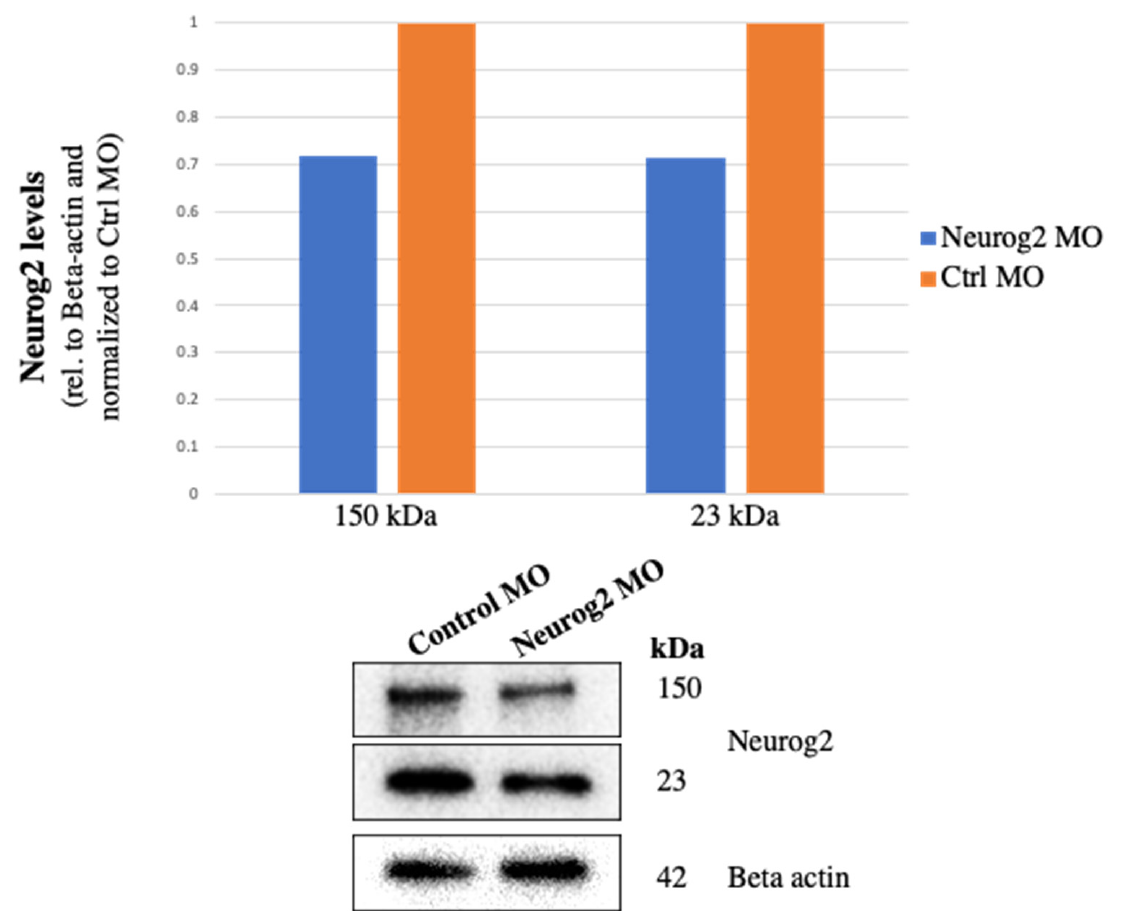
Figure 2. The Neurog2 MO reduces Neurog2 protein levels. At ~E1.5 (HH9 + to 10), placode cells were unilaterally electroporated either with a Neurog2 or control (Ctrl) MO. After re-incubation to E2.5–3 (HH16–18), the forming trigeminal ganglion on the electroporated side was dissected and pooled from multiple embryos. Lysates were prepared, and equivalent amounts of protein per sample were separated on a 10% SDS-PAGE gel. Immunoblotting for Neurog2 and Beta actin (control) was then performed, and band intensity was calculated from unmodified immunoblot images using Image Lab software (Bio-Rad). Relative protein levels were ascertained by normalizing Neurog2 volumes to Beta actin volumes. Knockdown amount was determined by comparing normalized ratios between Ctrl MO and Neurog2 MO samples, with the Ctrl MO sample set as one.